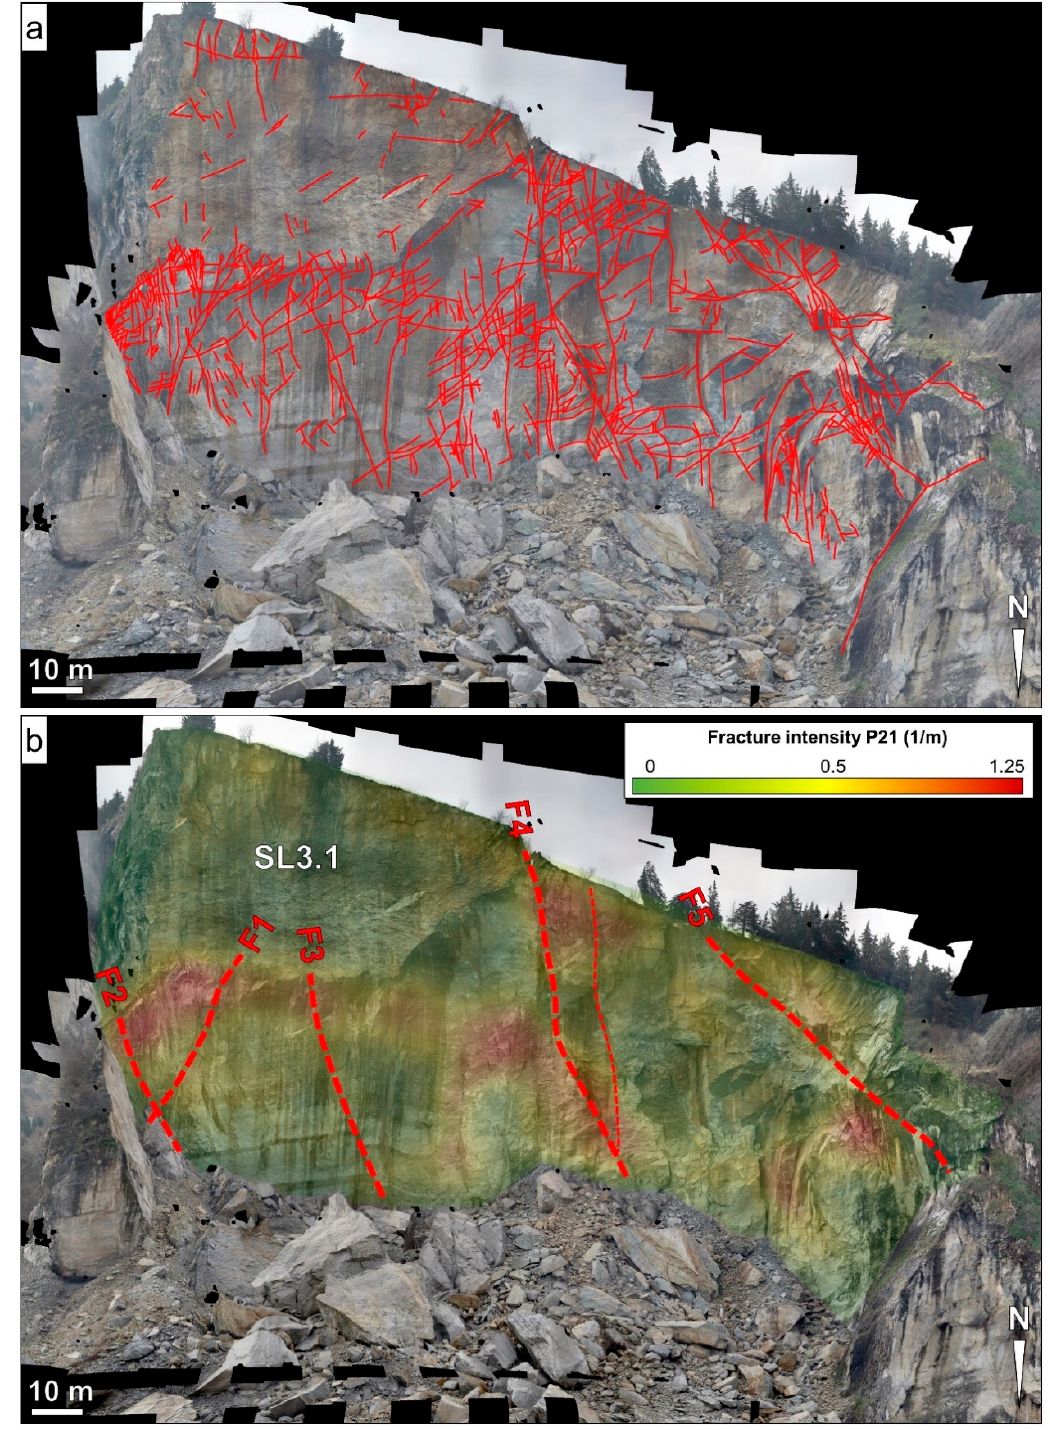
Figure 5. Overview of P 21 analysis. ( a ) Traces of the fractures mapped along the rupture surface; ( b ) P 21 distribution computed by dividing the orthorectified photograph in square cells.